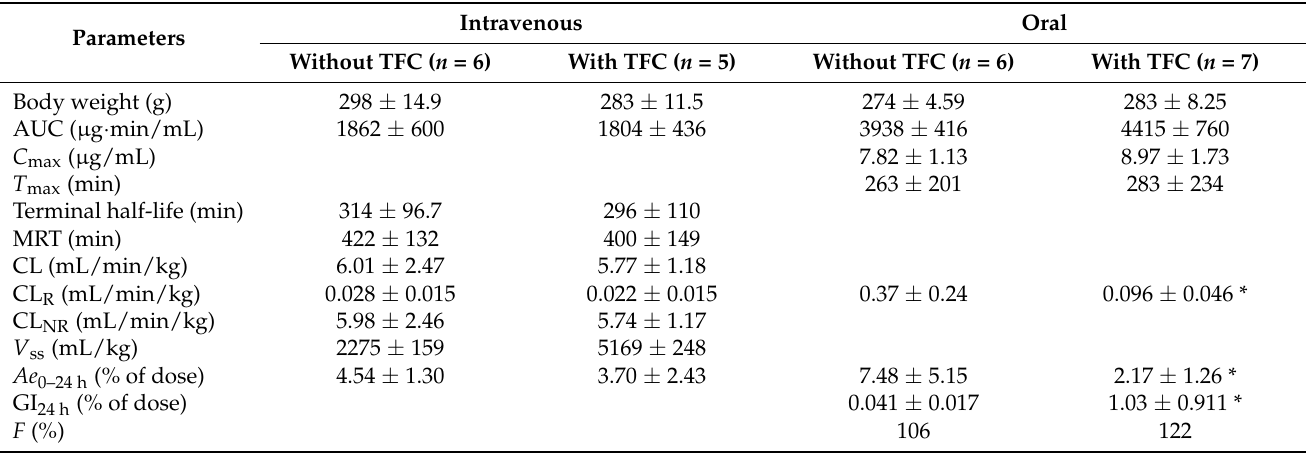
Table 2. Pharmacokinetic parameters of voriconazole after intravenous (10 mg/kg) and oral (20 mg/kg) administration of voriconazole without and with tofacitinib (TFC, 10 and 20 mg/kg for intravenous and oral administration, respectively) to Sprague–Dawley rats. Values are means ± standard deviation